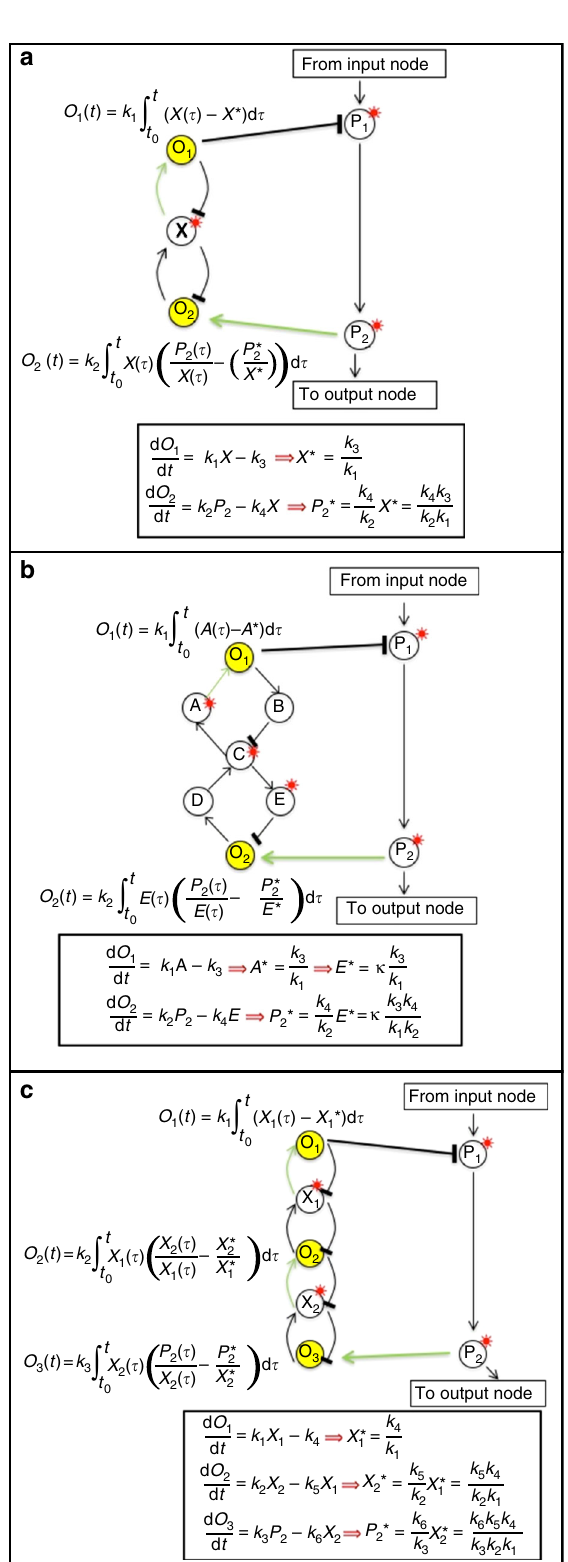
Fig. 3 Integral feedback control via three kinds of opposing sets. Three different examples of opposing sets, with the nature of the integral computed by each individual opposer node indicated in each case. Opposer nodes are indicated in yellow; a red superposed asterisk indicates nodes within each module that exhibit the RPA property due to the combined activities of the opposing set. Not only do all opposer nodes in the set contribute to an overall computation that allows one or more nodes in the opposed route to exhibit RPA, but one or more nodes in the master set must also exhibit the RPA property as part of this computation.